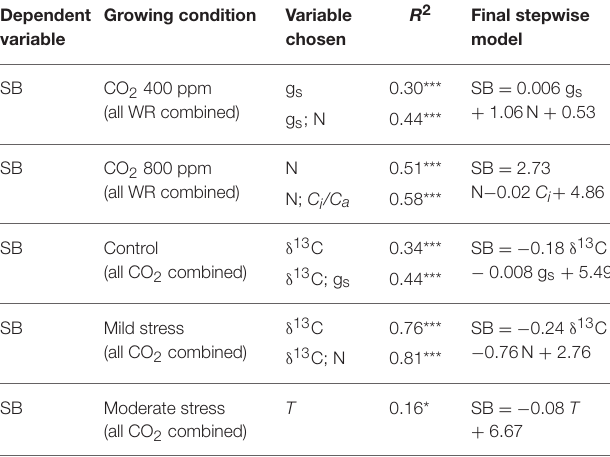
TABLE 4 | Multiple linear regressions (stepwise) explaining shoot biomass (SB) variation across genotypic groups in each CO 2 concentration and all water regimes (WR) combined and in each water regime condition and all [CO 2 ] combined as a dependent variable, and all the gas exchange traits and stables isotope signatures and nitrogen concentration in the same growing conditions as independent